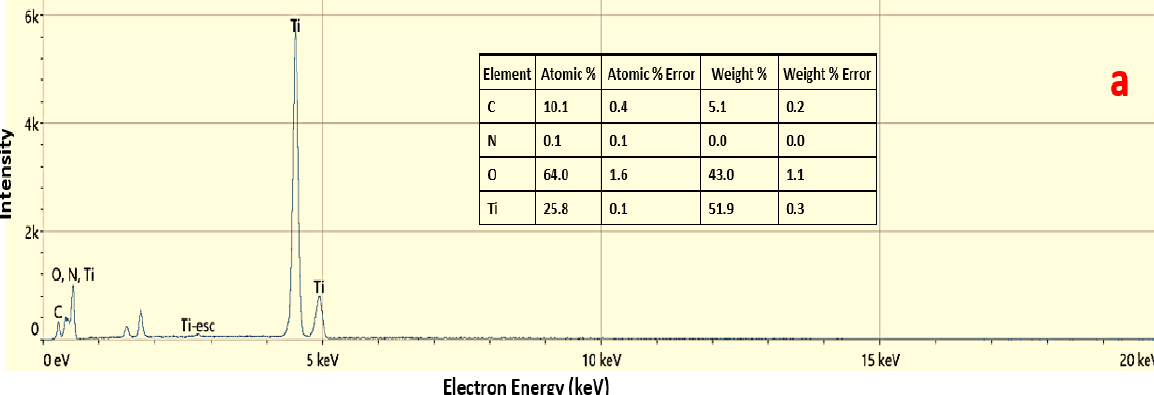
Figure 1. The EDS spectra showing the composition of ( a ) net TiO 2 and ( b ) 5.0 wt% N-TiO 2 . 2.1.2. Scanning Electron Microscopy (SEM) The morphological and structural characteristics of the catalyst have a significant im- pact on the photocatalytic activity. Figure 2a depicts the net TiO 2 SEM images with a mag- nification of 2400, 2500, and 5000× (50, 40, and 20 µm, respectively), while Figure 2b de- picts the 5 wt% N-TiO 2 SEM images with a magnification of 2400, 2500, and 5000× (50, 40, and 20 µm, respectively). The photocatalytic activity of the nanocomposite was increased due to the additional continuous link between the nanoparticles and nitrogen, allowing the passage of charge carriers during the photocatalysis [20]. It can be seen from Figure 2a that the aggregation of net TiO 2 is mostly made up of many irregular spherical-shaped TiO 2 nanoparticles, which are observed to have agglomerated, probably due to the calci- nation at 450 °C. However, a visible difference can be seen between the pristine TiO 2 de- picted in Figure 2a and the N-doped TiO 2 particles depicted in Figure 2b. The cluster-like shape formed by the N-doped TiO 2 could be due to morphological changes as a result of the nitrogen molecules chemically adhering to the TiO 2 particles. The doping of the TiO 2 with nitrogen could have induced smaller nanoparticles with good dispersibility, which could enhance the photoactivity of the TiO 2 catalyst in the degradation of the CIP from wastewater [31,34].